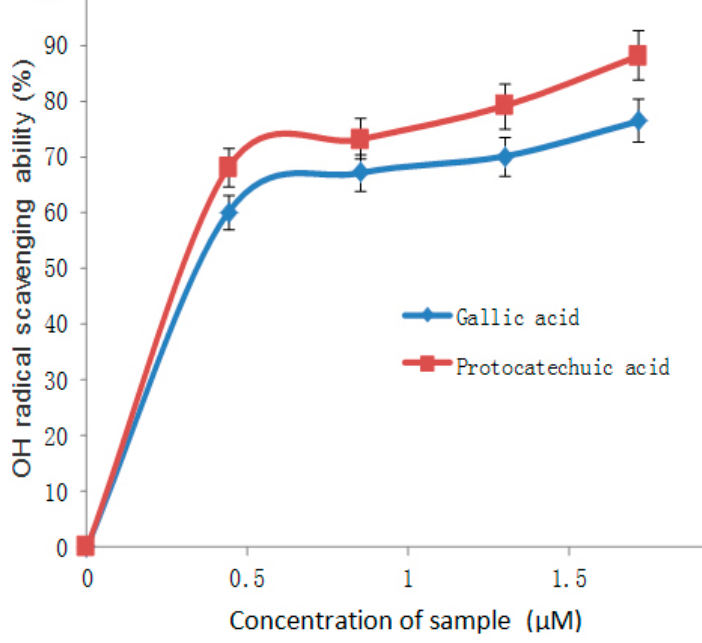
Figure 4. OH radical scavenging ability of gallic and protocatechuic acids.